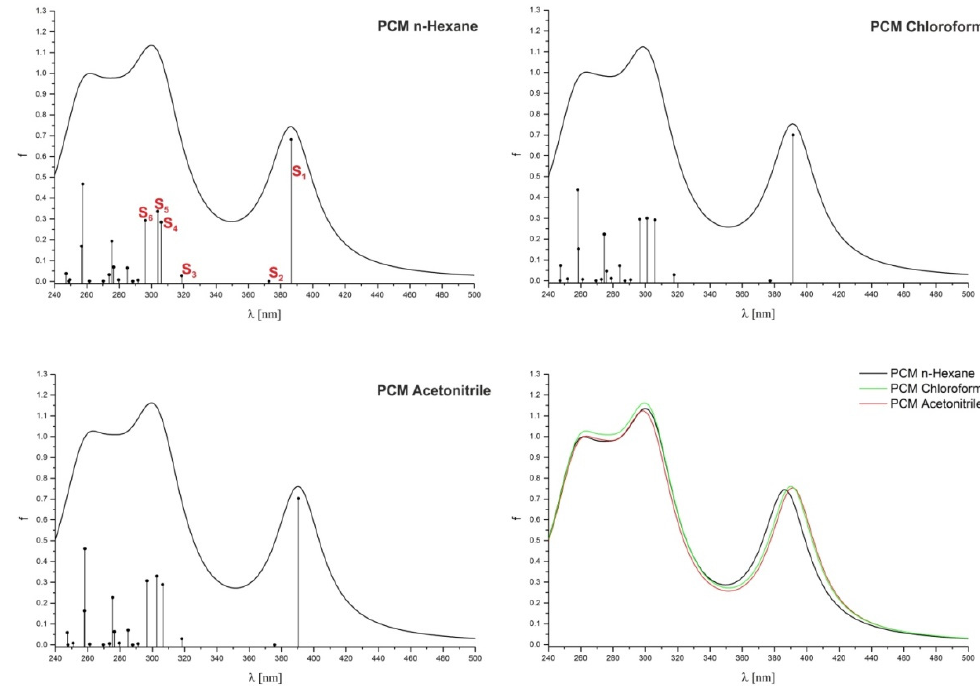
Figure 8. TD-DFT/PBE0 calculations of the tBuTPAterpy absorption spectra for three solvents, n - hexane, chloroform and acetonitrile, together with their excitation wavelengths and oscillator strengths, respectively, in the top left, top right, and bottom left panels. The bottom right panel shows the comparison of the three simulated spectra; TD-DFT—Time-Dependent Density Functional Theory.